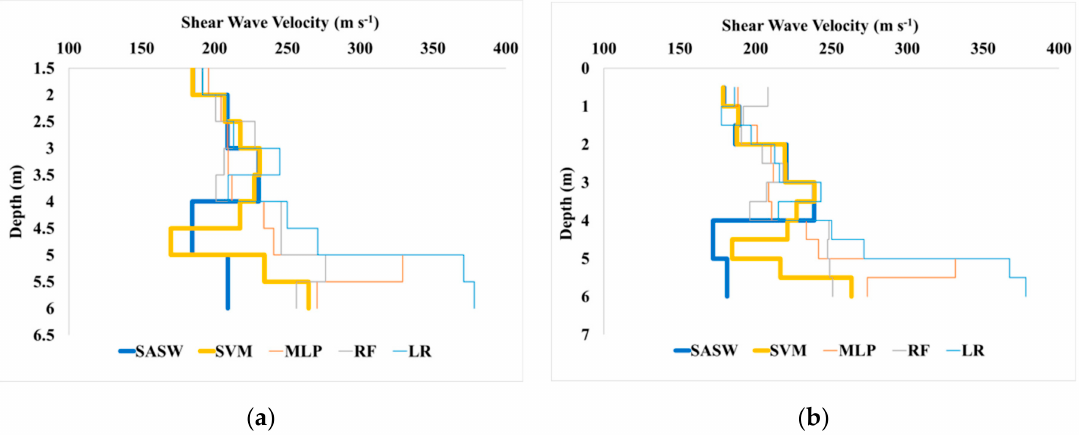
Figure 16. V S profiles from SASW inversion and ML algorithms for ( a ) test 7 and ( b ) test 8.